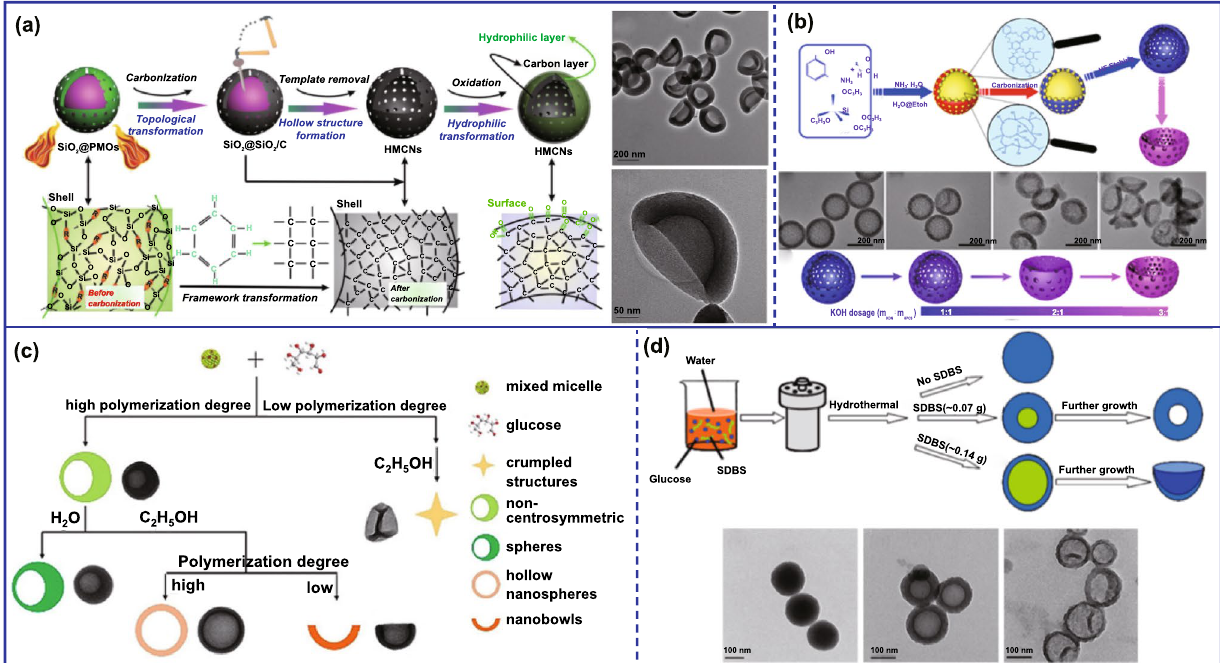
Fig. 3 Various synthetic strategies for preparing asymmetric pure carbon nanoparticles. a Alkali etching destroys the rigid structure to obtain a bowl-shaped carbon material. Reproduced with permission from Ref. [27]. Copyright 2013, Wiley–VCH. b Preparation of asymmetric carbon nanoparticles by subsequent activation pore-making. Reproduced with permission from Ref. [32]. Copyright 2018, American Chemical Society. c Selectively dissolving oligomers by solvents to obtain bowl-shaped carbon nanoparticles. Reproduced with permission from Ref. [33]. Copy- right 2018, Wiley–VCH. d Preparation of asymmetric carbon nanoparticles by adjusting the thickness of the precursor. Reproduced with permis- sion from Ref. [20]. Copyright 2015, Elsevier